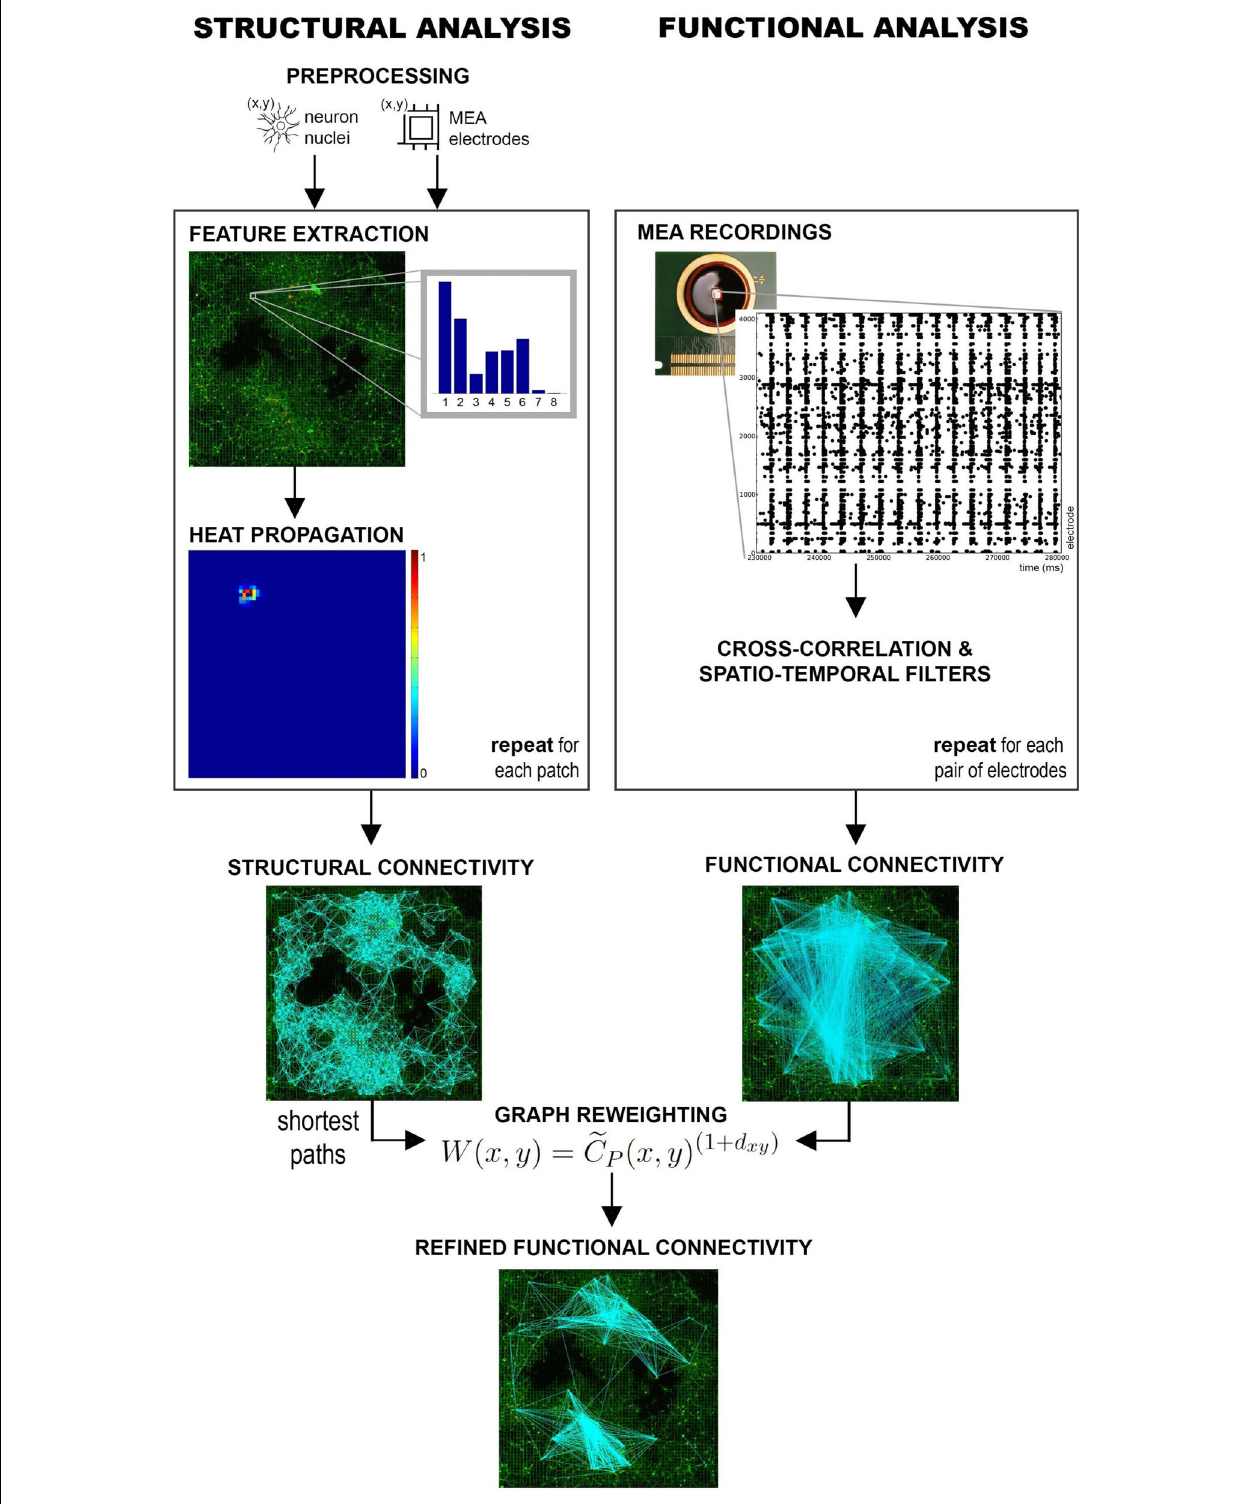
FIGURE 1 | Overview of the approach. Structural and functional connectivity maps are separately estimated from the multimodal datasets acquired on HD-MEAs. The functional graph is then refined using the structural information as